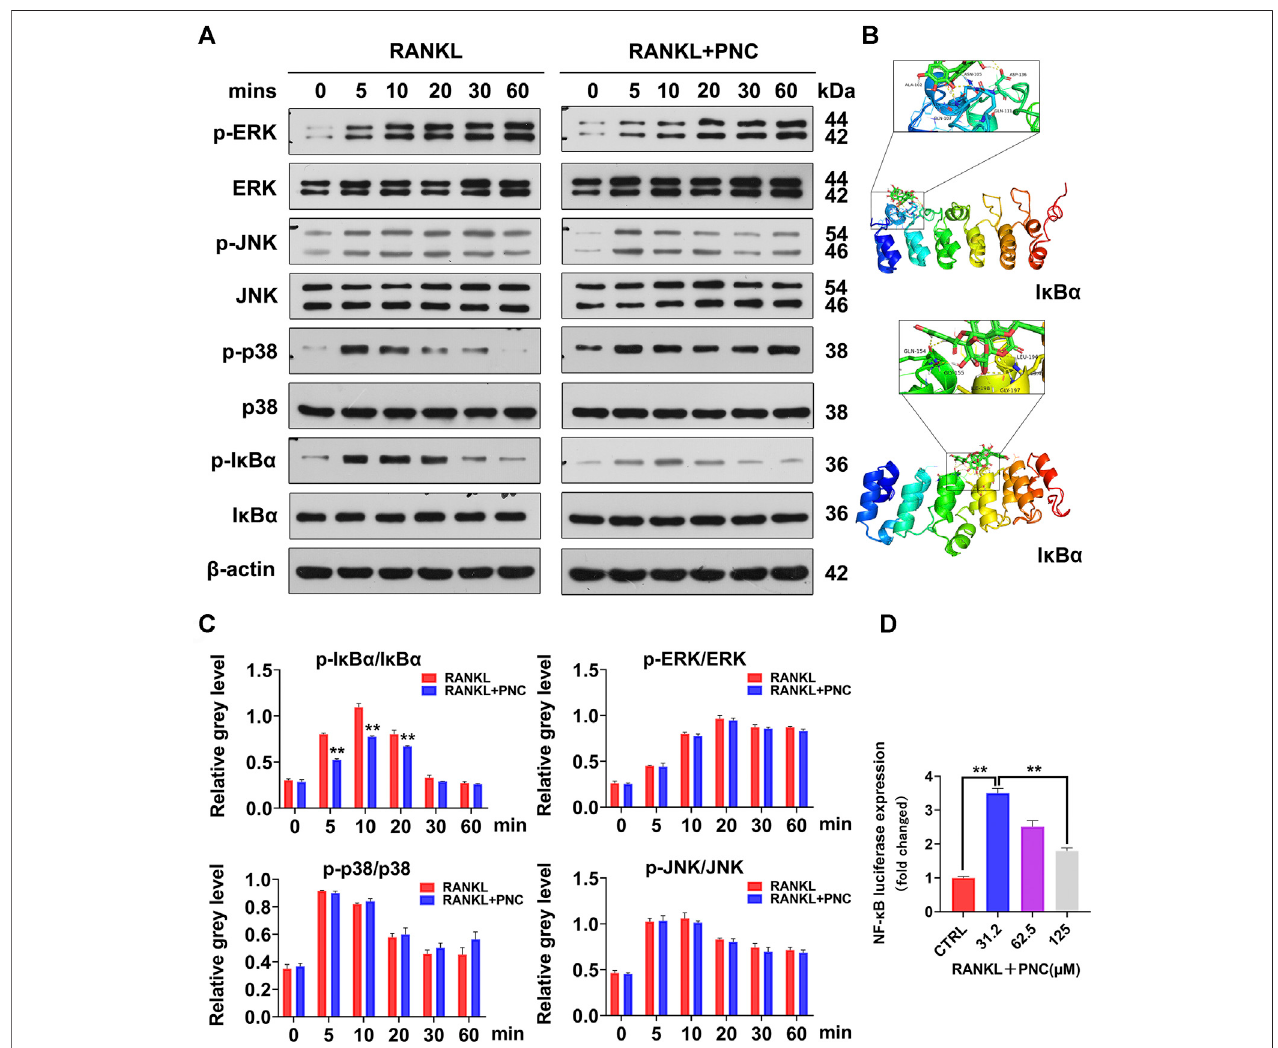
FIGURE3| PNCsuppressedRANKL-initiatedactivationoftheNF- κ Bsignalingpathway. (A) AssessmentoftheinhibitoryeffectsofPNConRANKL-mediatedNF- κ BandMAPKsignaling. (B) Molecular dockingofPNCwithI κ B α kinases. (C) PhosphorylatedI κ BarelativetoI κ Ba,phosphorylatedJNKrelativetoJNK,phosphorylated ERK relative to ERK, phosphorylated p38 relative to p38. (D) After culture with PNC and RANKL, the NF- κ B luciferase activity of the transfected RAW 264.7 cells were assessed. ** p < 0.05, ** p < 0.01 versus the control group.